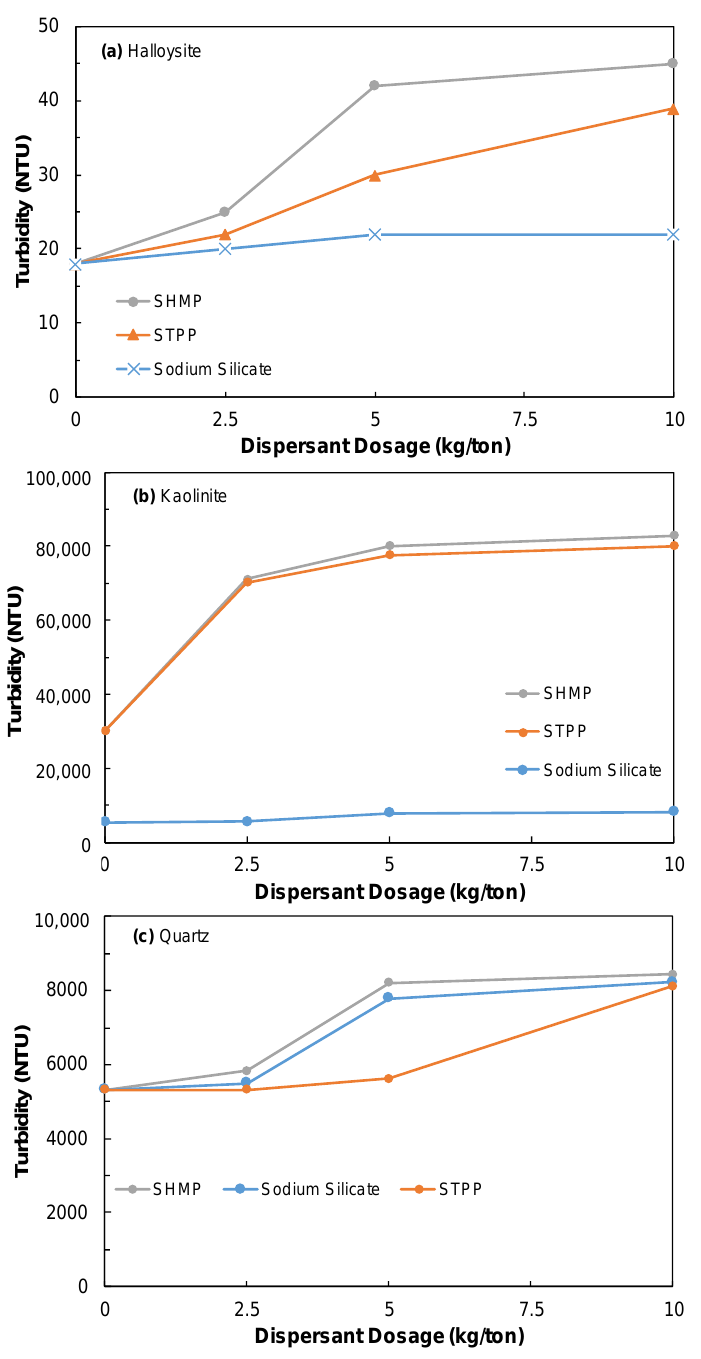
Figure 12. Turbidity measurements of ( a ) halloysite, ( b ) kaolinite, and ( c ) quartz according to dispersant types at natural pH and room temperature.